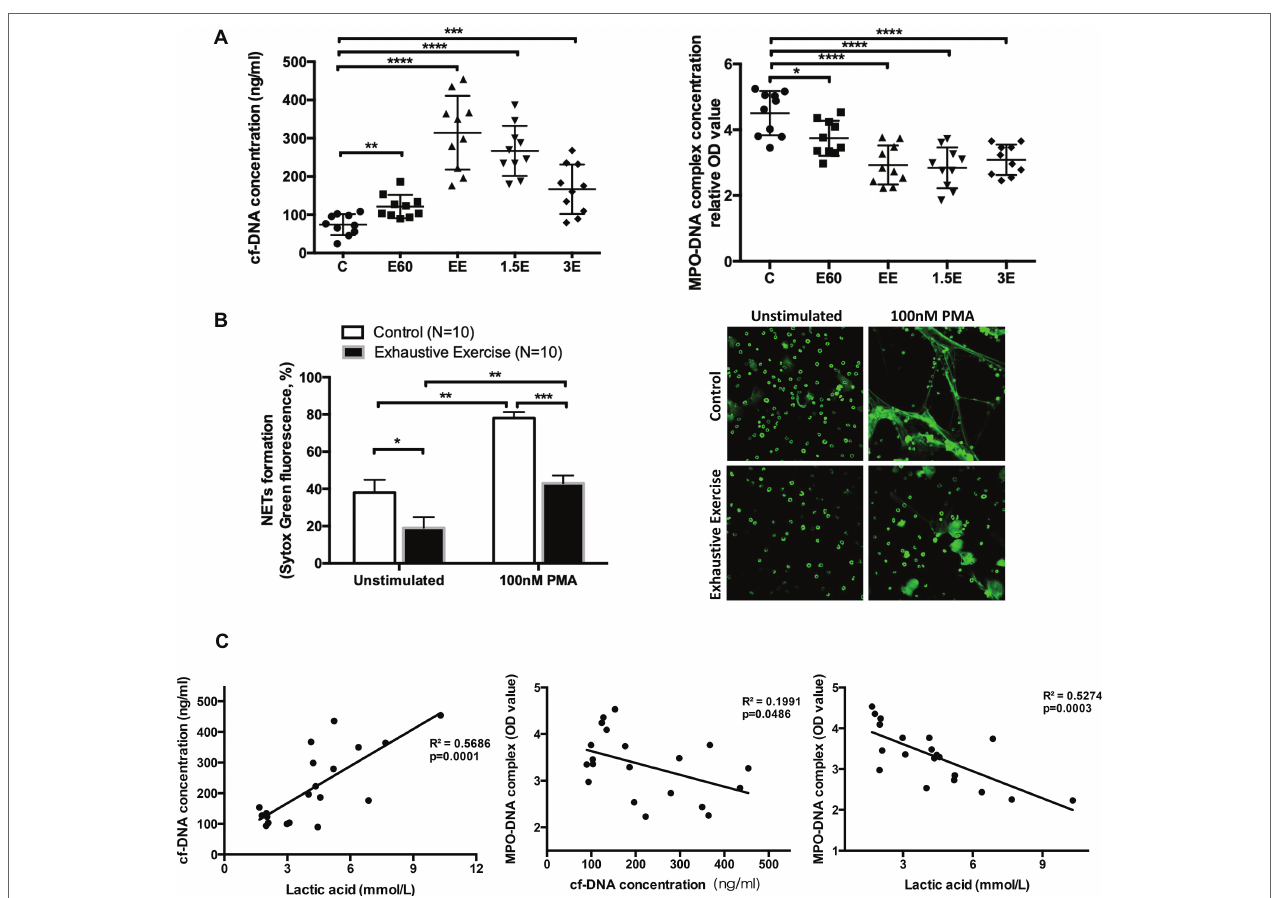
FIGURE 2 | Levels of cell-free DNA (cf-DNA) and MPO-DNA and correlation of cell-free DNA, LA, and MPO-DNA complex values. (A) The concentrations of serum cf-DNA were determined by PicoGreen. The serum levels of NETs and MPO-DNA complexes were measured by antibody capture ELISA methods. The symbols represent individual samples, and the data are expressed as mean ± SEM. C, control group; E60, incremental treadmill running for 60 min; EE, exhaustive incremental running for about 145 min; 1.5E, 1.5 h recovery after exhaustive running; 3E, 3 h recovery after exhaustive running. (B) NETs release was determined using a fluorescence microplate reader or observed by immunofluorescence microscopy with SytoxGreen extracellular DNA staining. Neutrophils isolated from fresh peripheral blood from the Control (C) group or EE group mice were seeded into 96-well plates and treated with media only or 100 nM PMA for 4 h. Original magnification 400×. (C) The correlation between concentrations of cell-free DNA, LA, and MPO-DNA complex values. * indicates p < 0.05, ** indicates p < 0.001, *** indicates p < 0.005, and **** indicates p <